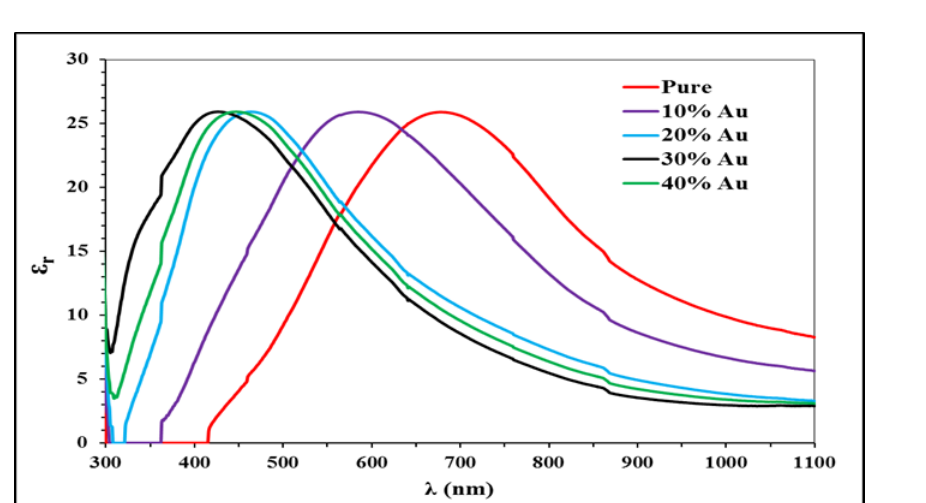
and doped of Au (0, 10, 20, 30 3